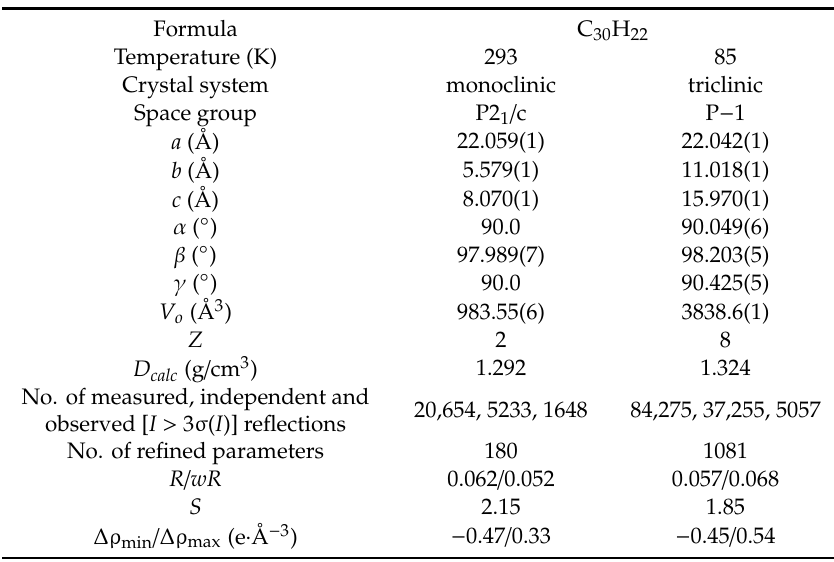
Table 1. Crystallographic characteristics, experimental data and structure refinement parameters of